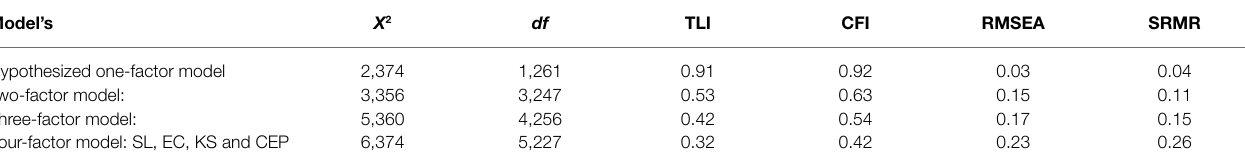
TABLE 3 | Results of the confirmatory factor analysis ( N = 299).